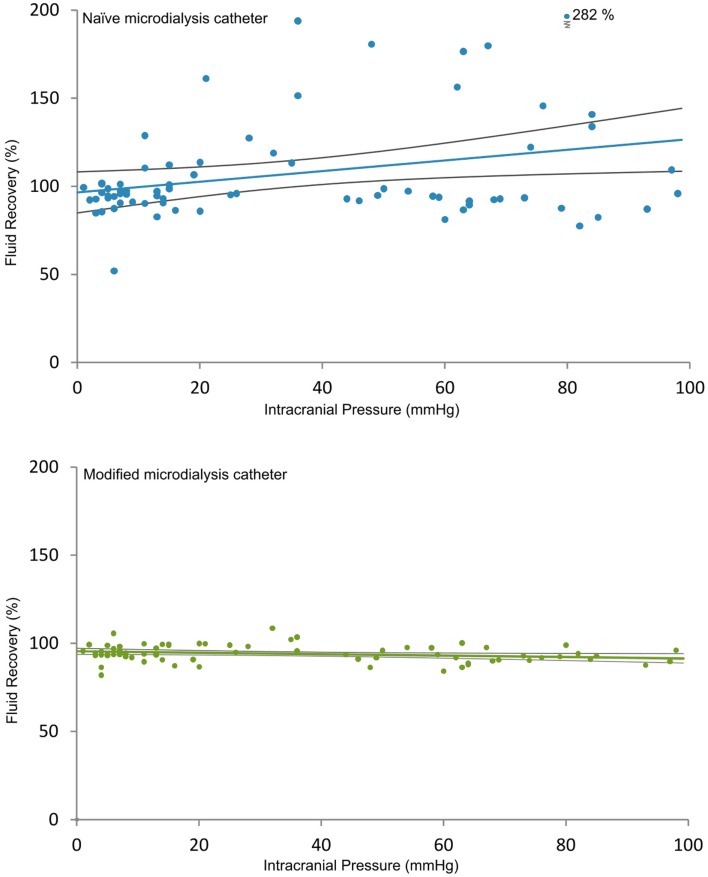
Relation between fluid recovery and ICP for naïve and modified MD catheters is shown. The two diagrams show the relation between FR and ICP for the naïve (upper) and the modified (lower) MD catheters (100 kDa Brain Microdialysis Catheter, M Dialysis AB), both perfused (1 μL/min) with Perfusion Fluid CNS with in-house addition of 3% Dextran 500 (kDa). Each circle is the FR of an individual MD vial plotted against the mean ICP at the end of each corresponding 20-min period. A linear regression line is plotted with 95% confidence interval. Upper panel shows a significant positive correlation between FR and ICP in naïve MD catheters with a high degree of variability (r = 0.30, p = 0.02, Standard Error of Estimate = 32.3). Lower panel shows that this correlation switched to a weak negative relation in modified catheters with markedly reduced scatter (r = −0.04, p = 0.04, Standard Error of Estimate = 4.8), suggesting a more stable MD performance as a result of surface modification (16). Reprinted with permission from Dahlin et al. (16). Copyright American Chemical Society.